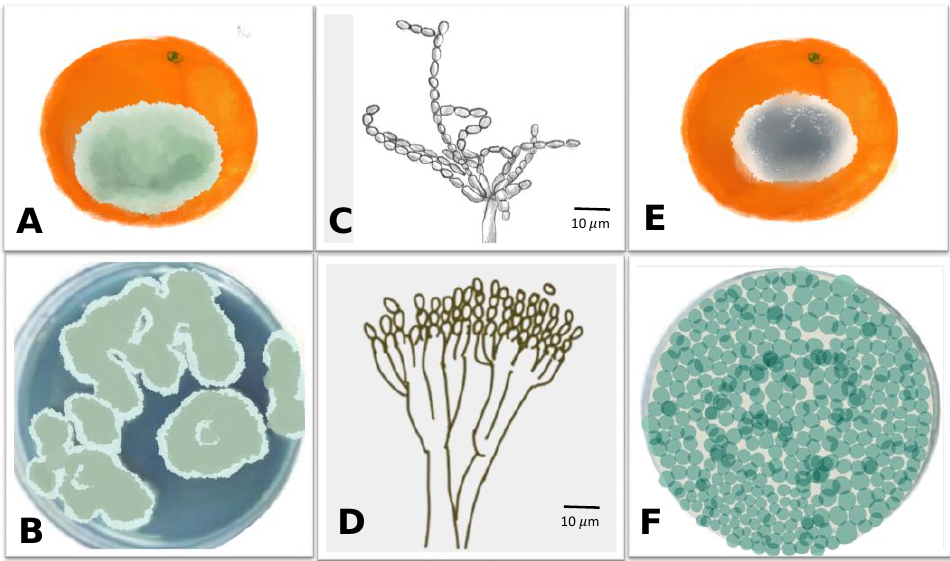
Figure 4. Green and blue molds caused by Penicillium spp., ( A , E ) = the symptom on fruit from P. digitatum and P. italicum ; ( B , F ) = colony from P. digitatum and P. italicum and ( C , D ) = conidia morphology from P. italicum and P. digitatum.